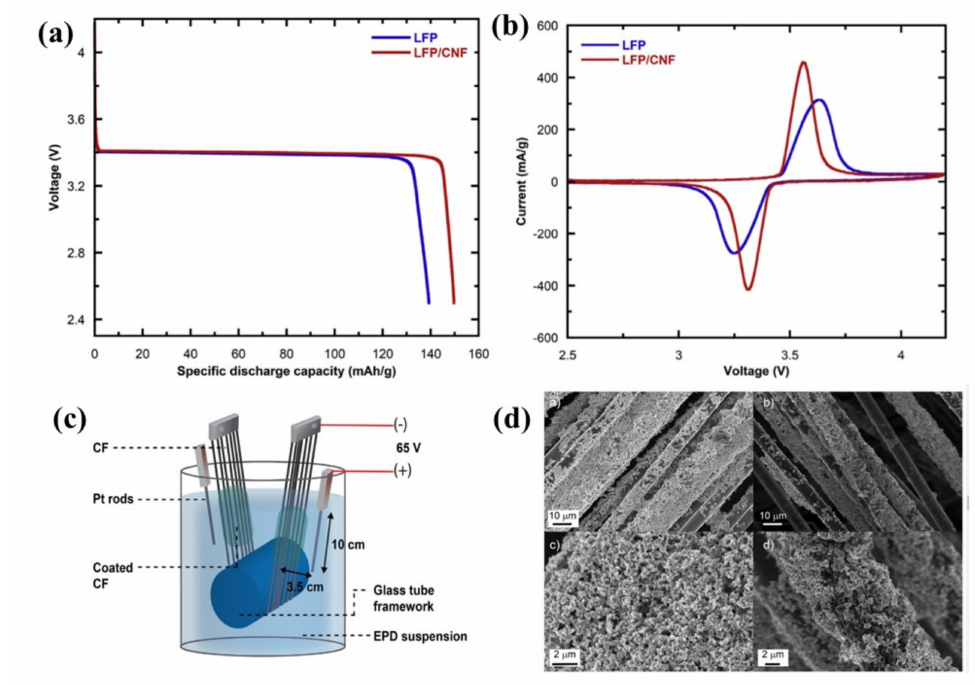
Figure 5. ( a ) Discharge curves of LFP and LFP/CNF at 0.1 C ( b ) CV curves of LFP and LFP/CNF at 0.1 mVs − 1 (adapted with permission from Ref. [48]. 2020 Elsevier). ( c ) Schematic illustration of electrophoretic deposition ( d ) SEM images of homogeneous deposition. (adapted with permission from Ref. [49]. 2018